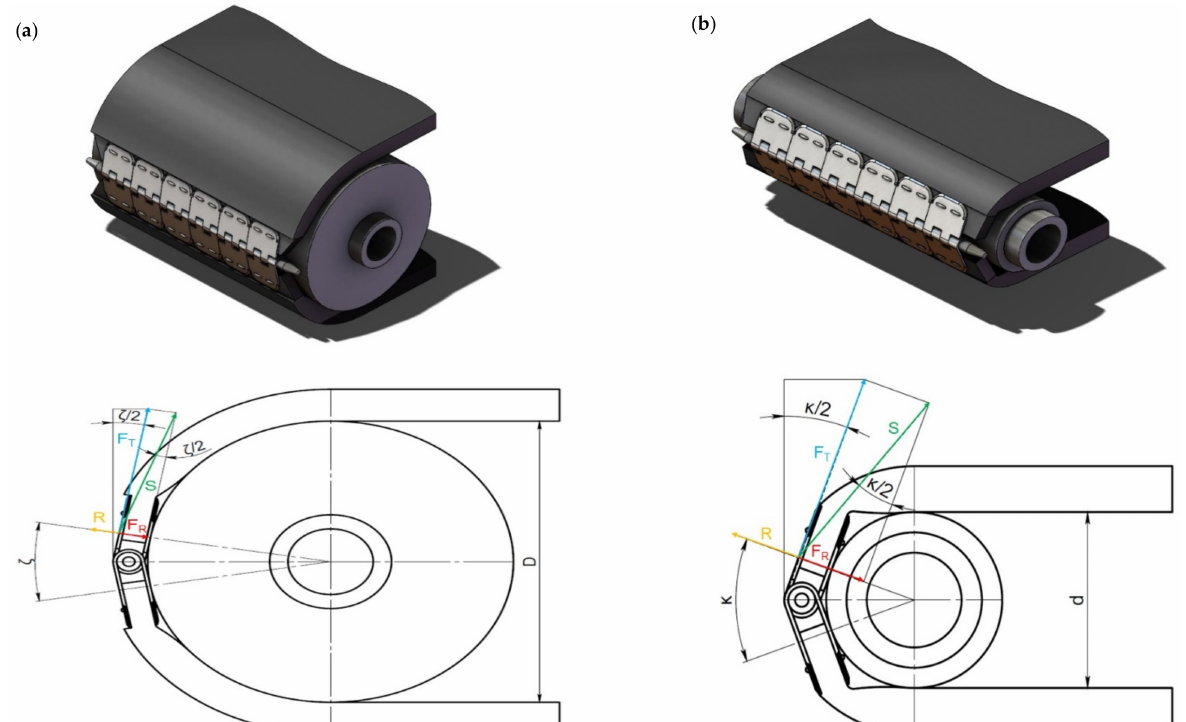
Figure 5. Drawing summarizing the analytical evidence that the minimum roll diameter requirement in the context of two conveyor systems with the same loading parameters is in fact a geometric problem: ( a ) a larger diameter roll, ( b ) a smaller diameter roll. Explanation: ζ —opening angle of the hinge connection plates in the arrangement with the larger roller, κ —opening angle of the hinge connection plates in the arrangement with the larger roller, D —larger diameter, d —smaller diameter, S —force in the tendon (green), F T —tangential force (blue), F R —radial force (red), R —the force of reaction (yellow) that actually causes the staples to detach from the